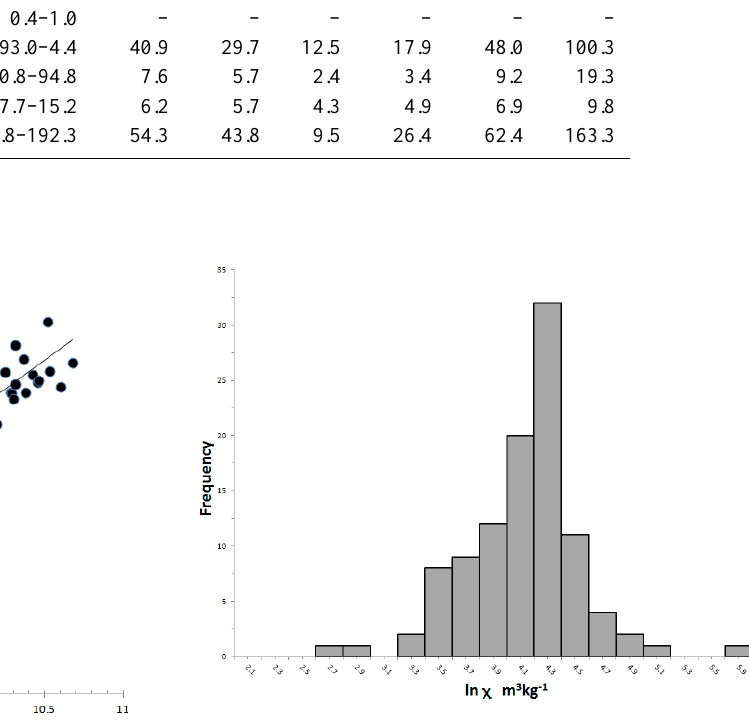
Fig. 4. Histogram of topsoil mass specific susceptibility.